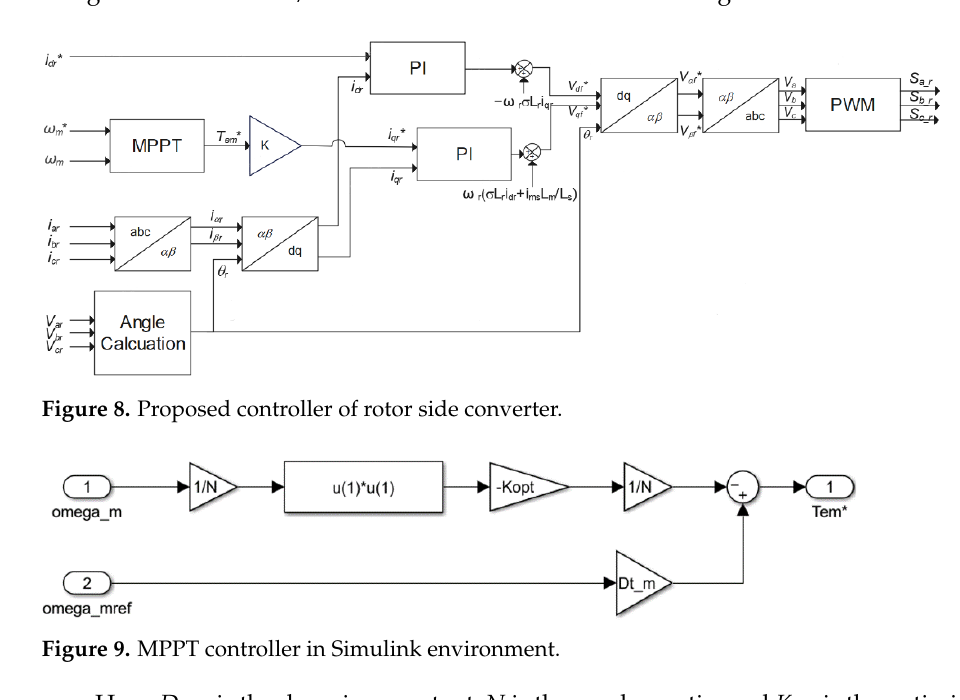
Figure 7. MPPT controller applied to the rotor-side converter.